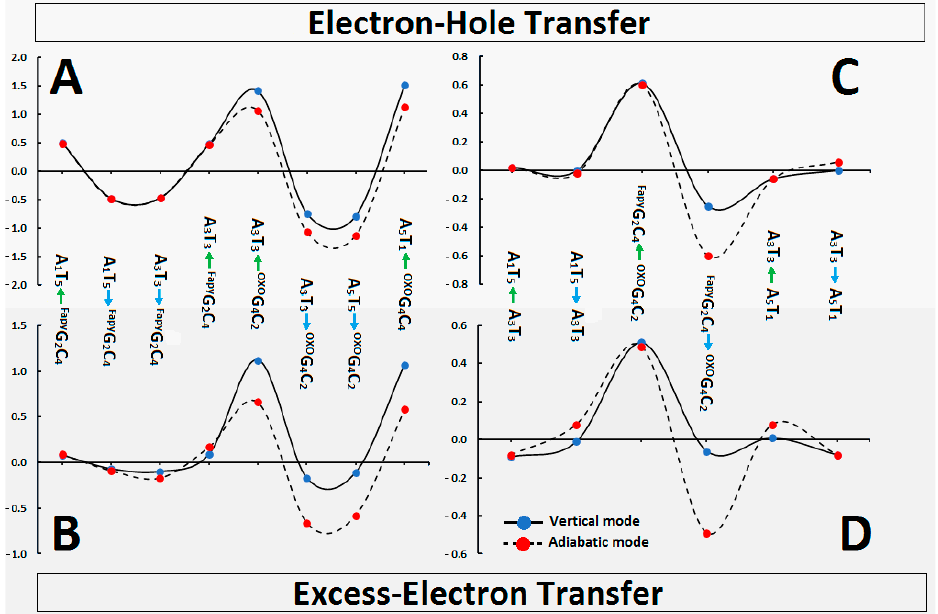
Figure 5. In [eV], the energy barrier profile of the charge migration process through the oligo- Fapy G contained CDL in vertical (black line and blue spot) and adiabatic (black dash and red spot) modes. ( A , B ) represented the direct transfer between neighbour base pairs, ( C , D ) the transfer over the single BP bridge. The numeric data has been given in Table S5.